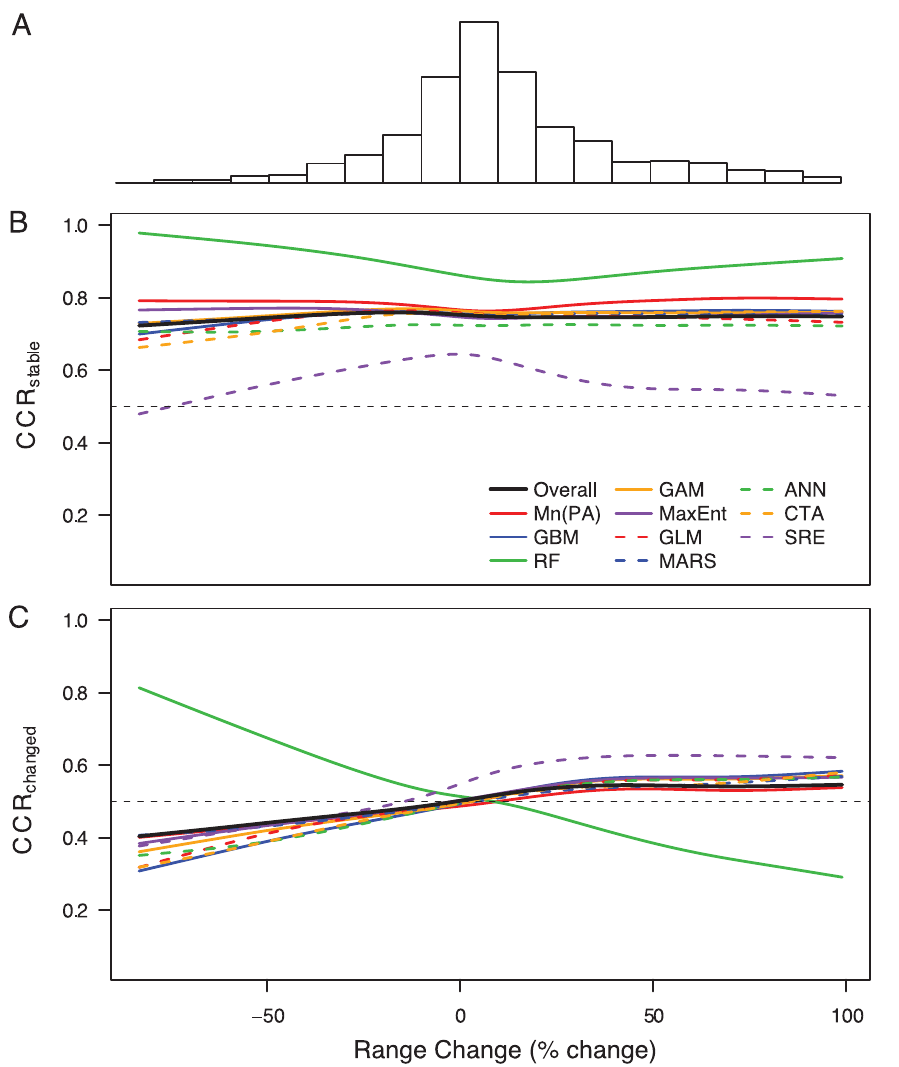
Figure 3. Accuracy of forecasted changes in species occupancy. Accuracy of predicted changes in occupancy between t 1 and t 2 as a function of species’ observed proportional range change between t 1 and t 2 : (A) histogram of the frequency of species’ proportional range change values; (B) correct classification rate across stable grid squares (i.e., those that have remained either occupied or unoccupied between time periods; CCR stable ) as a function of observed proportional range change, overall and for each modelling technique; (C) correct classification rate across changed grid squares (i.e., those that have changed occupancy status between time periods; CCR changed ) as a function of observed proportional range change, overall and for each modelling technique. Functions were fitted using generalised additive models (GAM; using a cubic spline smoother with 4 degrees of freedom). This analysis was limited to species experiencing a proportional change between 2 100% and + 100% (i.e., 85% of all species), due to the very high influence of the few species whose range more than doubled. The dashed line in panels (B) and (C) represents the value of CCR expected from a random guess (i.e., CCR =0.5).